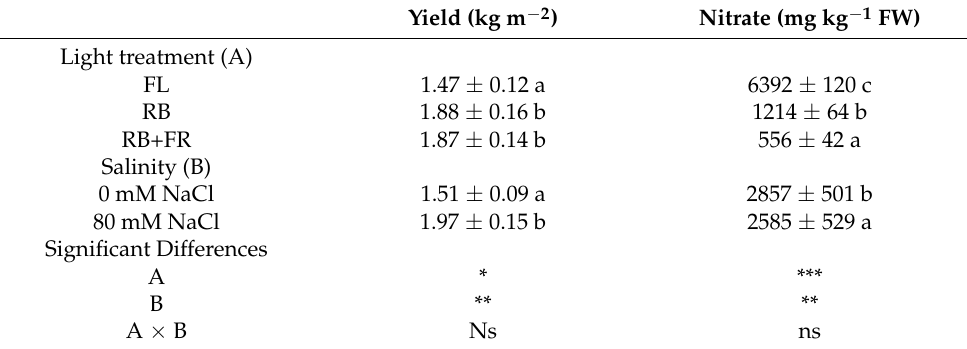
Table 1. Influence of light treatment and salinity (80 mM NaCl) on yield and nitrate content of purslane